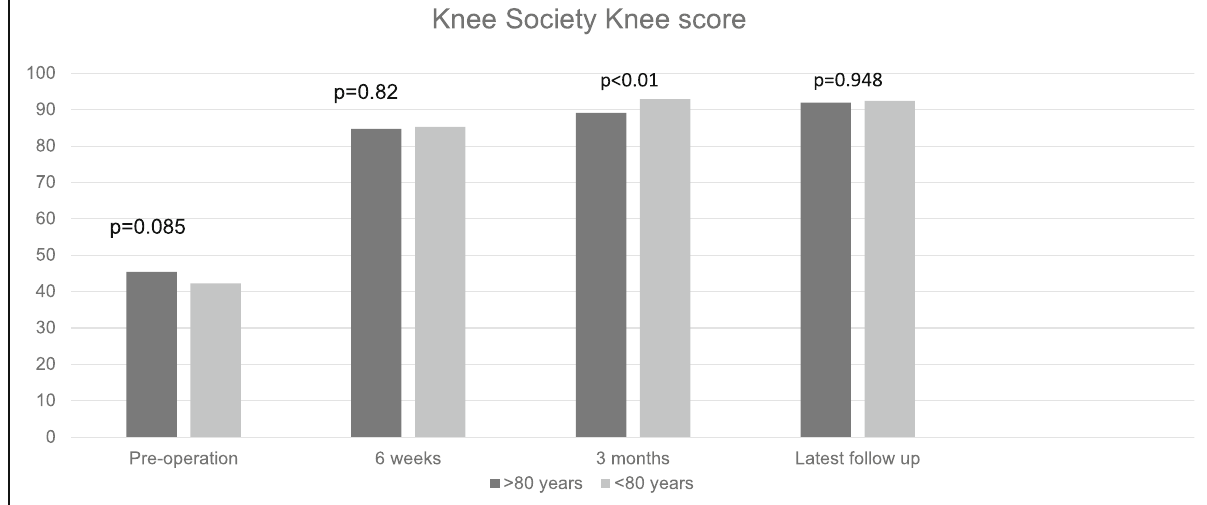
Fig. 1 KSKS at various time points for both the elderly and control